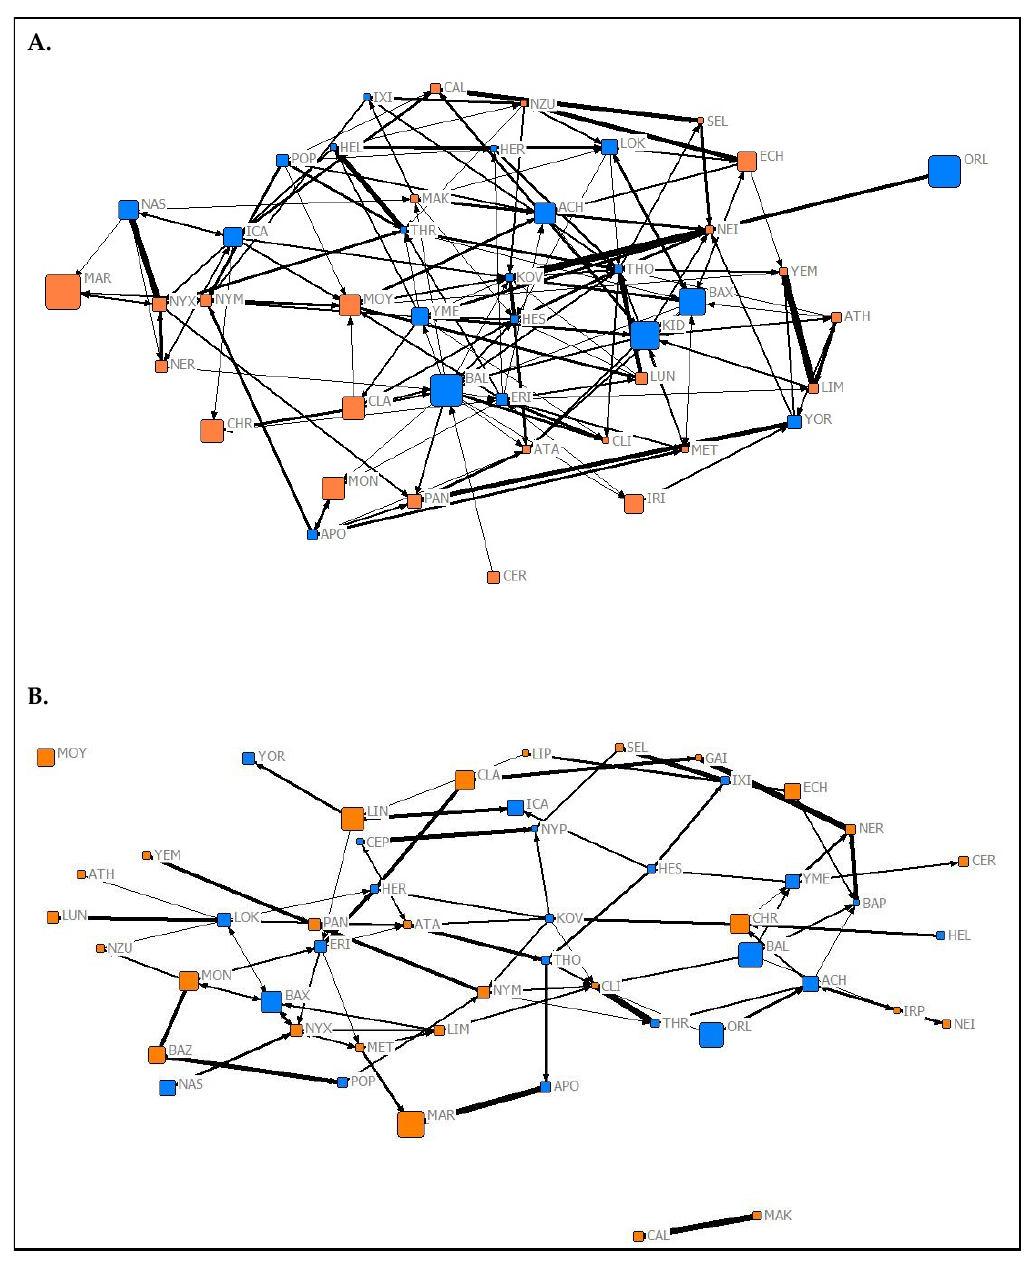
Figure 3. Graphical representations of the observed aggression networks from ( A ) Summer 2019 and ( B ) Spring 2020 of captive P. livingstonii . Nodes are labelled with their assigned three letter codes. Blue nodes denote male individuals, and orange denote females. The size of each node corresponds to the age in years of the individual during respective data collection periods with older individuals represented by larger nodes. The width of each tie increases with the weight of the edge. Non-metric geo-distances with node repulsion were used to create the layout, meaning nodes with more similar ties are closer together and nodes that are more central to the network are placed closer to the centre of the graph.